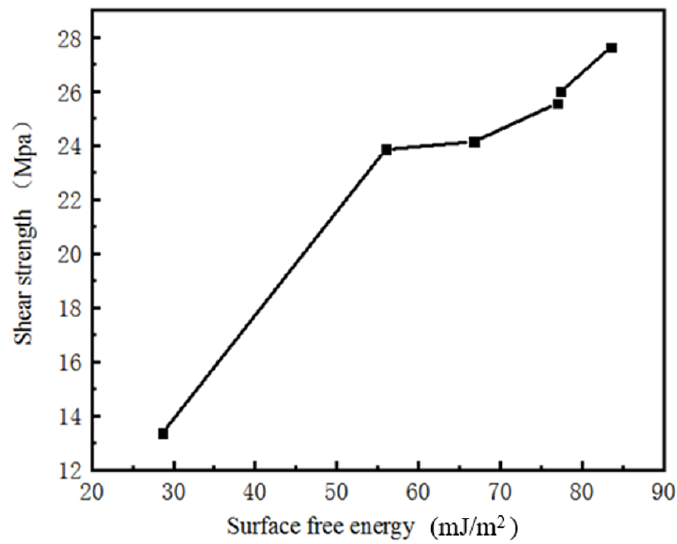
Figure 10. The shear strength of samples with different surface free energy.